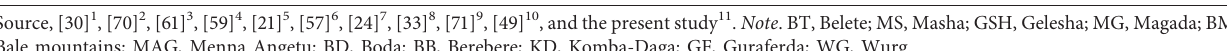
Table 7: Comparison of the basal area of Wurg forest with basal areas of other 10 Afromontane forests in Ethiopia. Forest